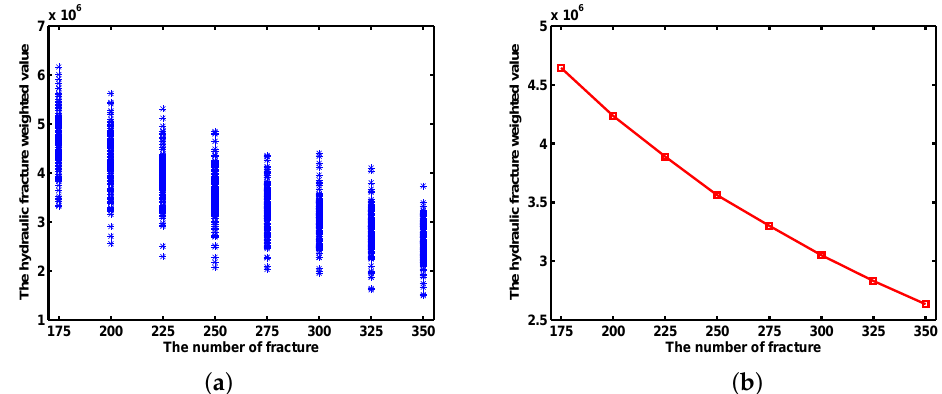
Figure 12. The influence of fracture number ( n ) on the hydraulic fracture weighted value. Here, α = 30 ◦ , l = 0.2 m, and the angle between two groups fracture remains orthogonal. Eight kinds of fracture numbers (175, 200, 225, 250, 275, 300, 325 and 350) have been analyzed, with 150 groups of randomly generated fractures for each kind of fracture number. ( a ) scatter distribution of the the hydraulic fracture weighted value with different values of n ; ( b ) average of the hydraulic fracture weighted value with different values of n .